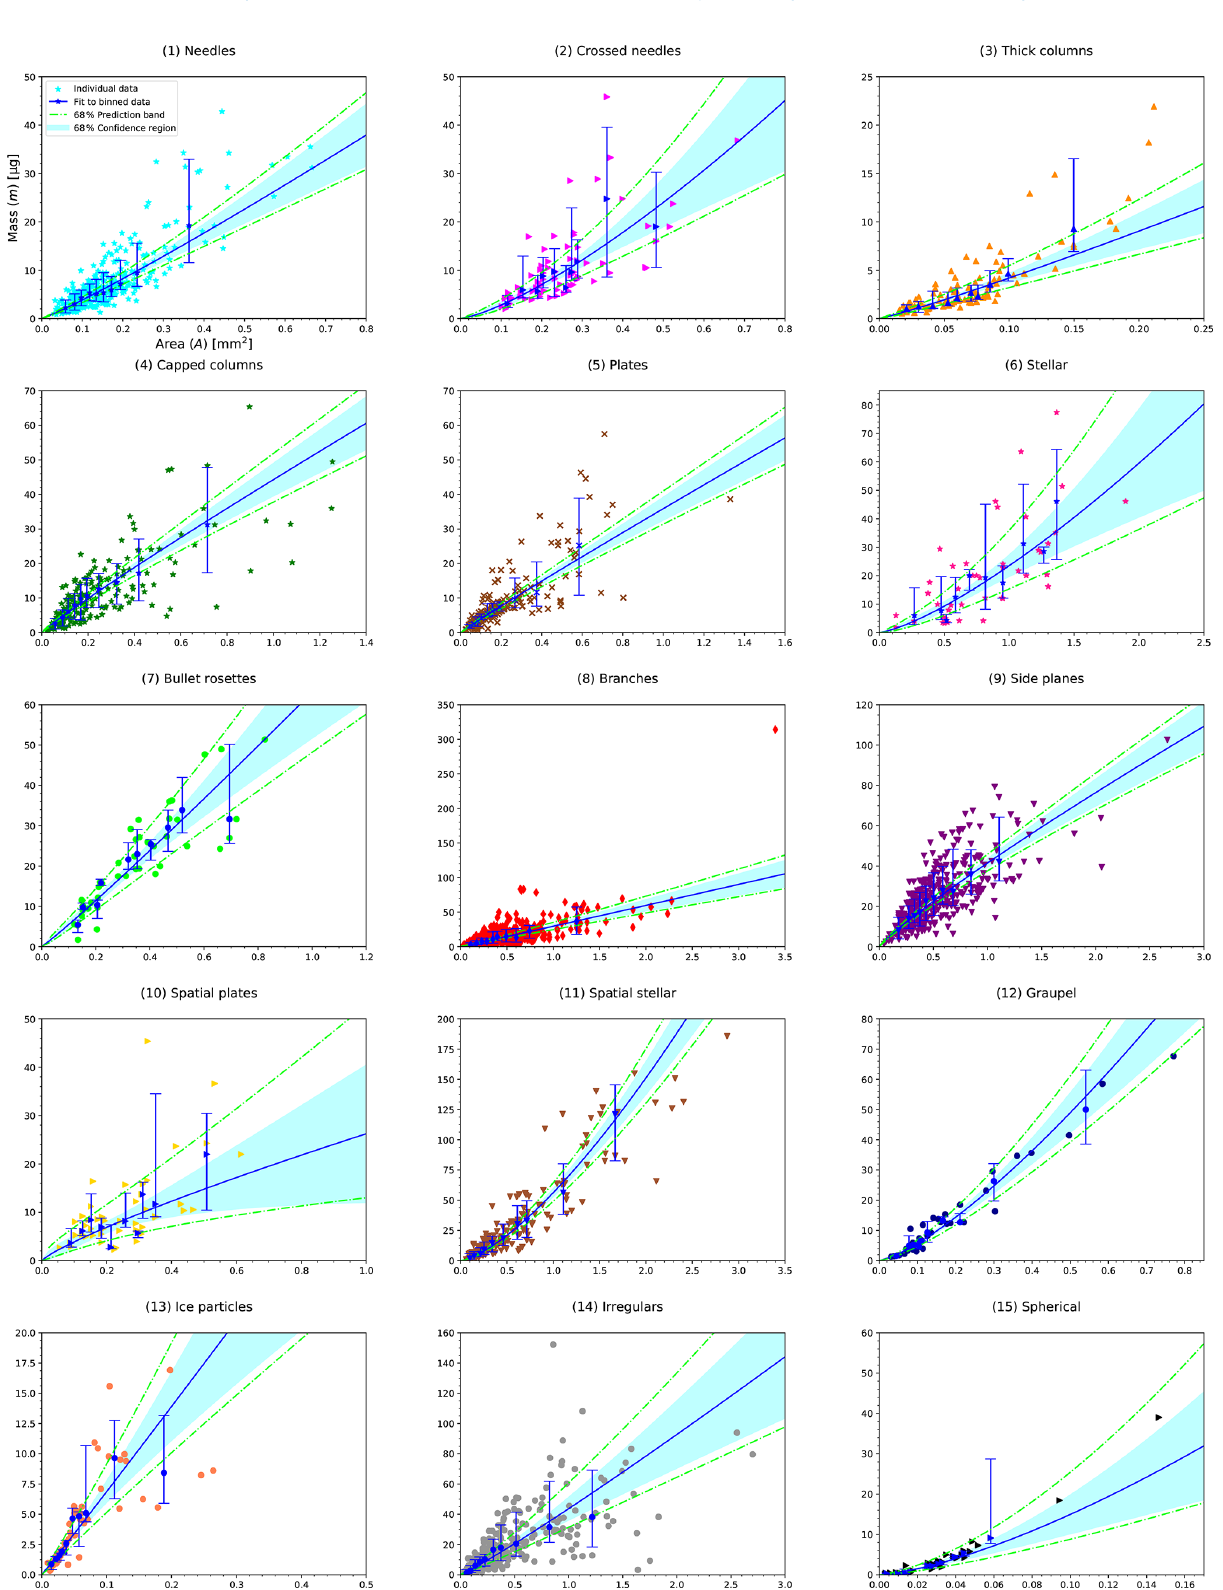
Figure A2. Same as Fig. A1, but mass vs. cross-sectional area ( m vs. A ) relationships given by Eq. (9) are shown